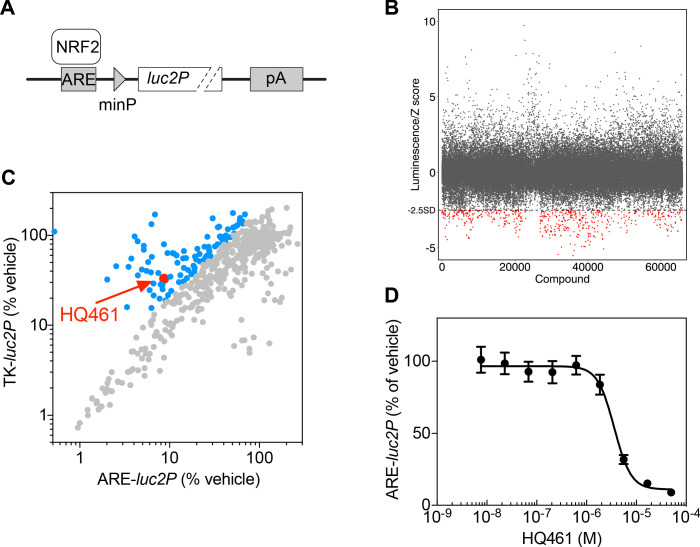
High-throughput chemical screening of NRF2 inhibitors.(A) ARE-luc2P reporter used for high-throughput screening. NRF2 binds to anti-oxidant response elements (ARE) to drive luciferase (luc2P) expression. (B) Primary screen results. The ARE-luc2P reporter cell line was treated for 12 hr with library compounds at 10 µM. Each screening plate was individually Z-score normalized, and all the Z-scores were aggregated. The dotted line represents the cutoff (Z-score <−2.5). Red dots mark hits from the primary screen. (C) Counter screen results. Hits from the primary screen were tested in both ARE-luc2P and TK-luc2P reporter cell lines at 10 µM for 12 hr. Blue dots represent compounds selectively inhibiting ARE-luc2P relative to TK-luc2P. (D) Measurement of the HQ461 IC50 on ARE-luc2P activity (IC50 = 3.6 µM, 95% CI: 2.9 µM-4.5 µM). Error bars represent standard errors of the mean (SEM) from three biological replicates.